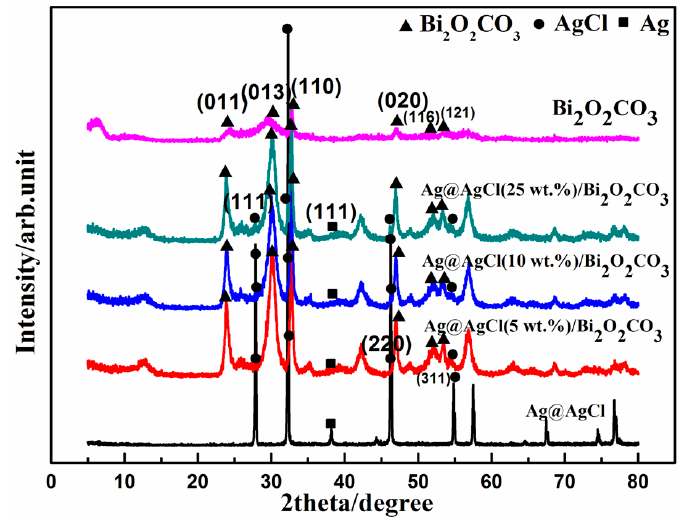
Figure 2. XRD pattern of Ag@AgCl, Bi 2 O 2 CO 3 and Ag@AgCl/Bi 2 O 2 CO 3 composites.